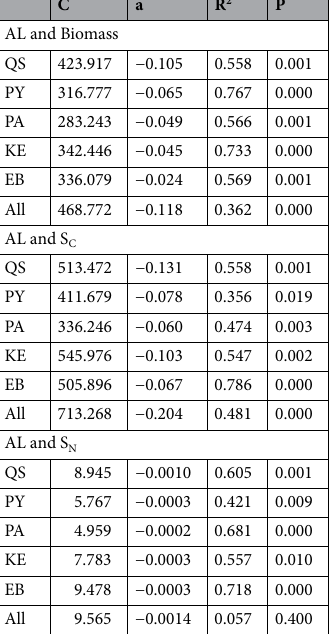
Table 4. The results of the generalized linear model analyses of the effects of altitude on biomass, S C and S N . Three linear models were built: model I: Biomass (t ha −1 ) = C + a × AL (altitude, m); model II: S C (t ha −1 ) = C + a × AL (altitude, m); and model III: S N (t ha −1 ) = C + a × AL (altitude, m), where C is the regression constant and a is the regression coefficient of the given